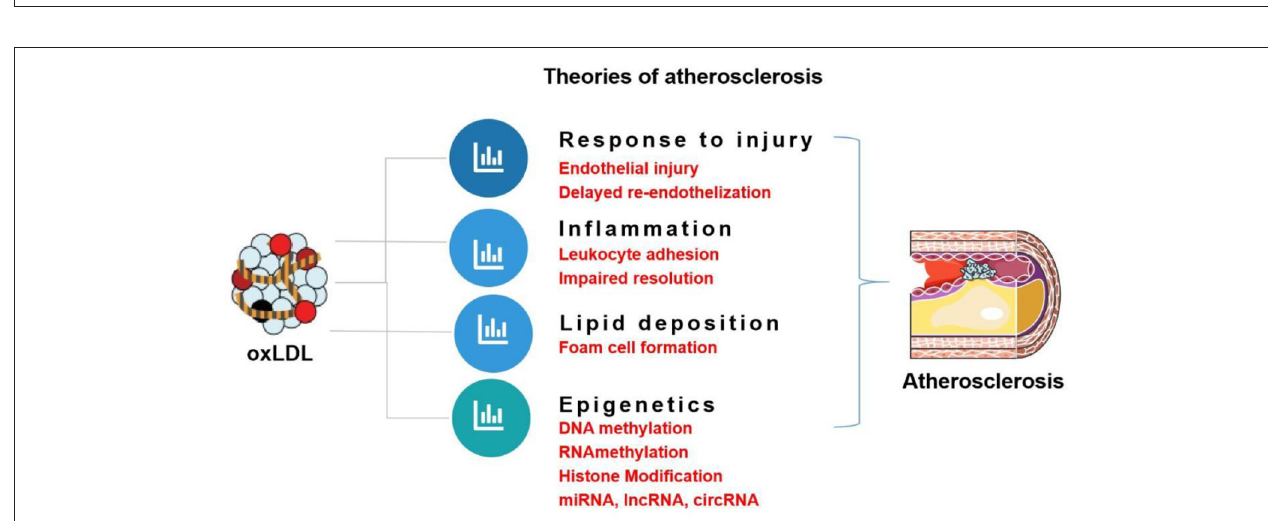
FIGURE 3 | Endothelial pro-atherogenic events and signaling pathways mediated by oxLDL.